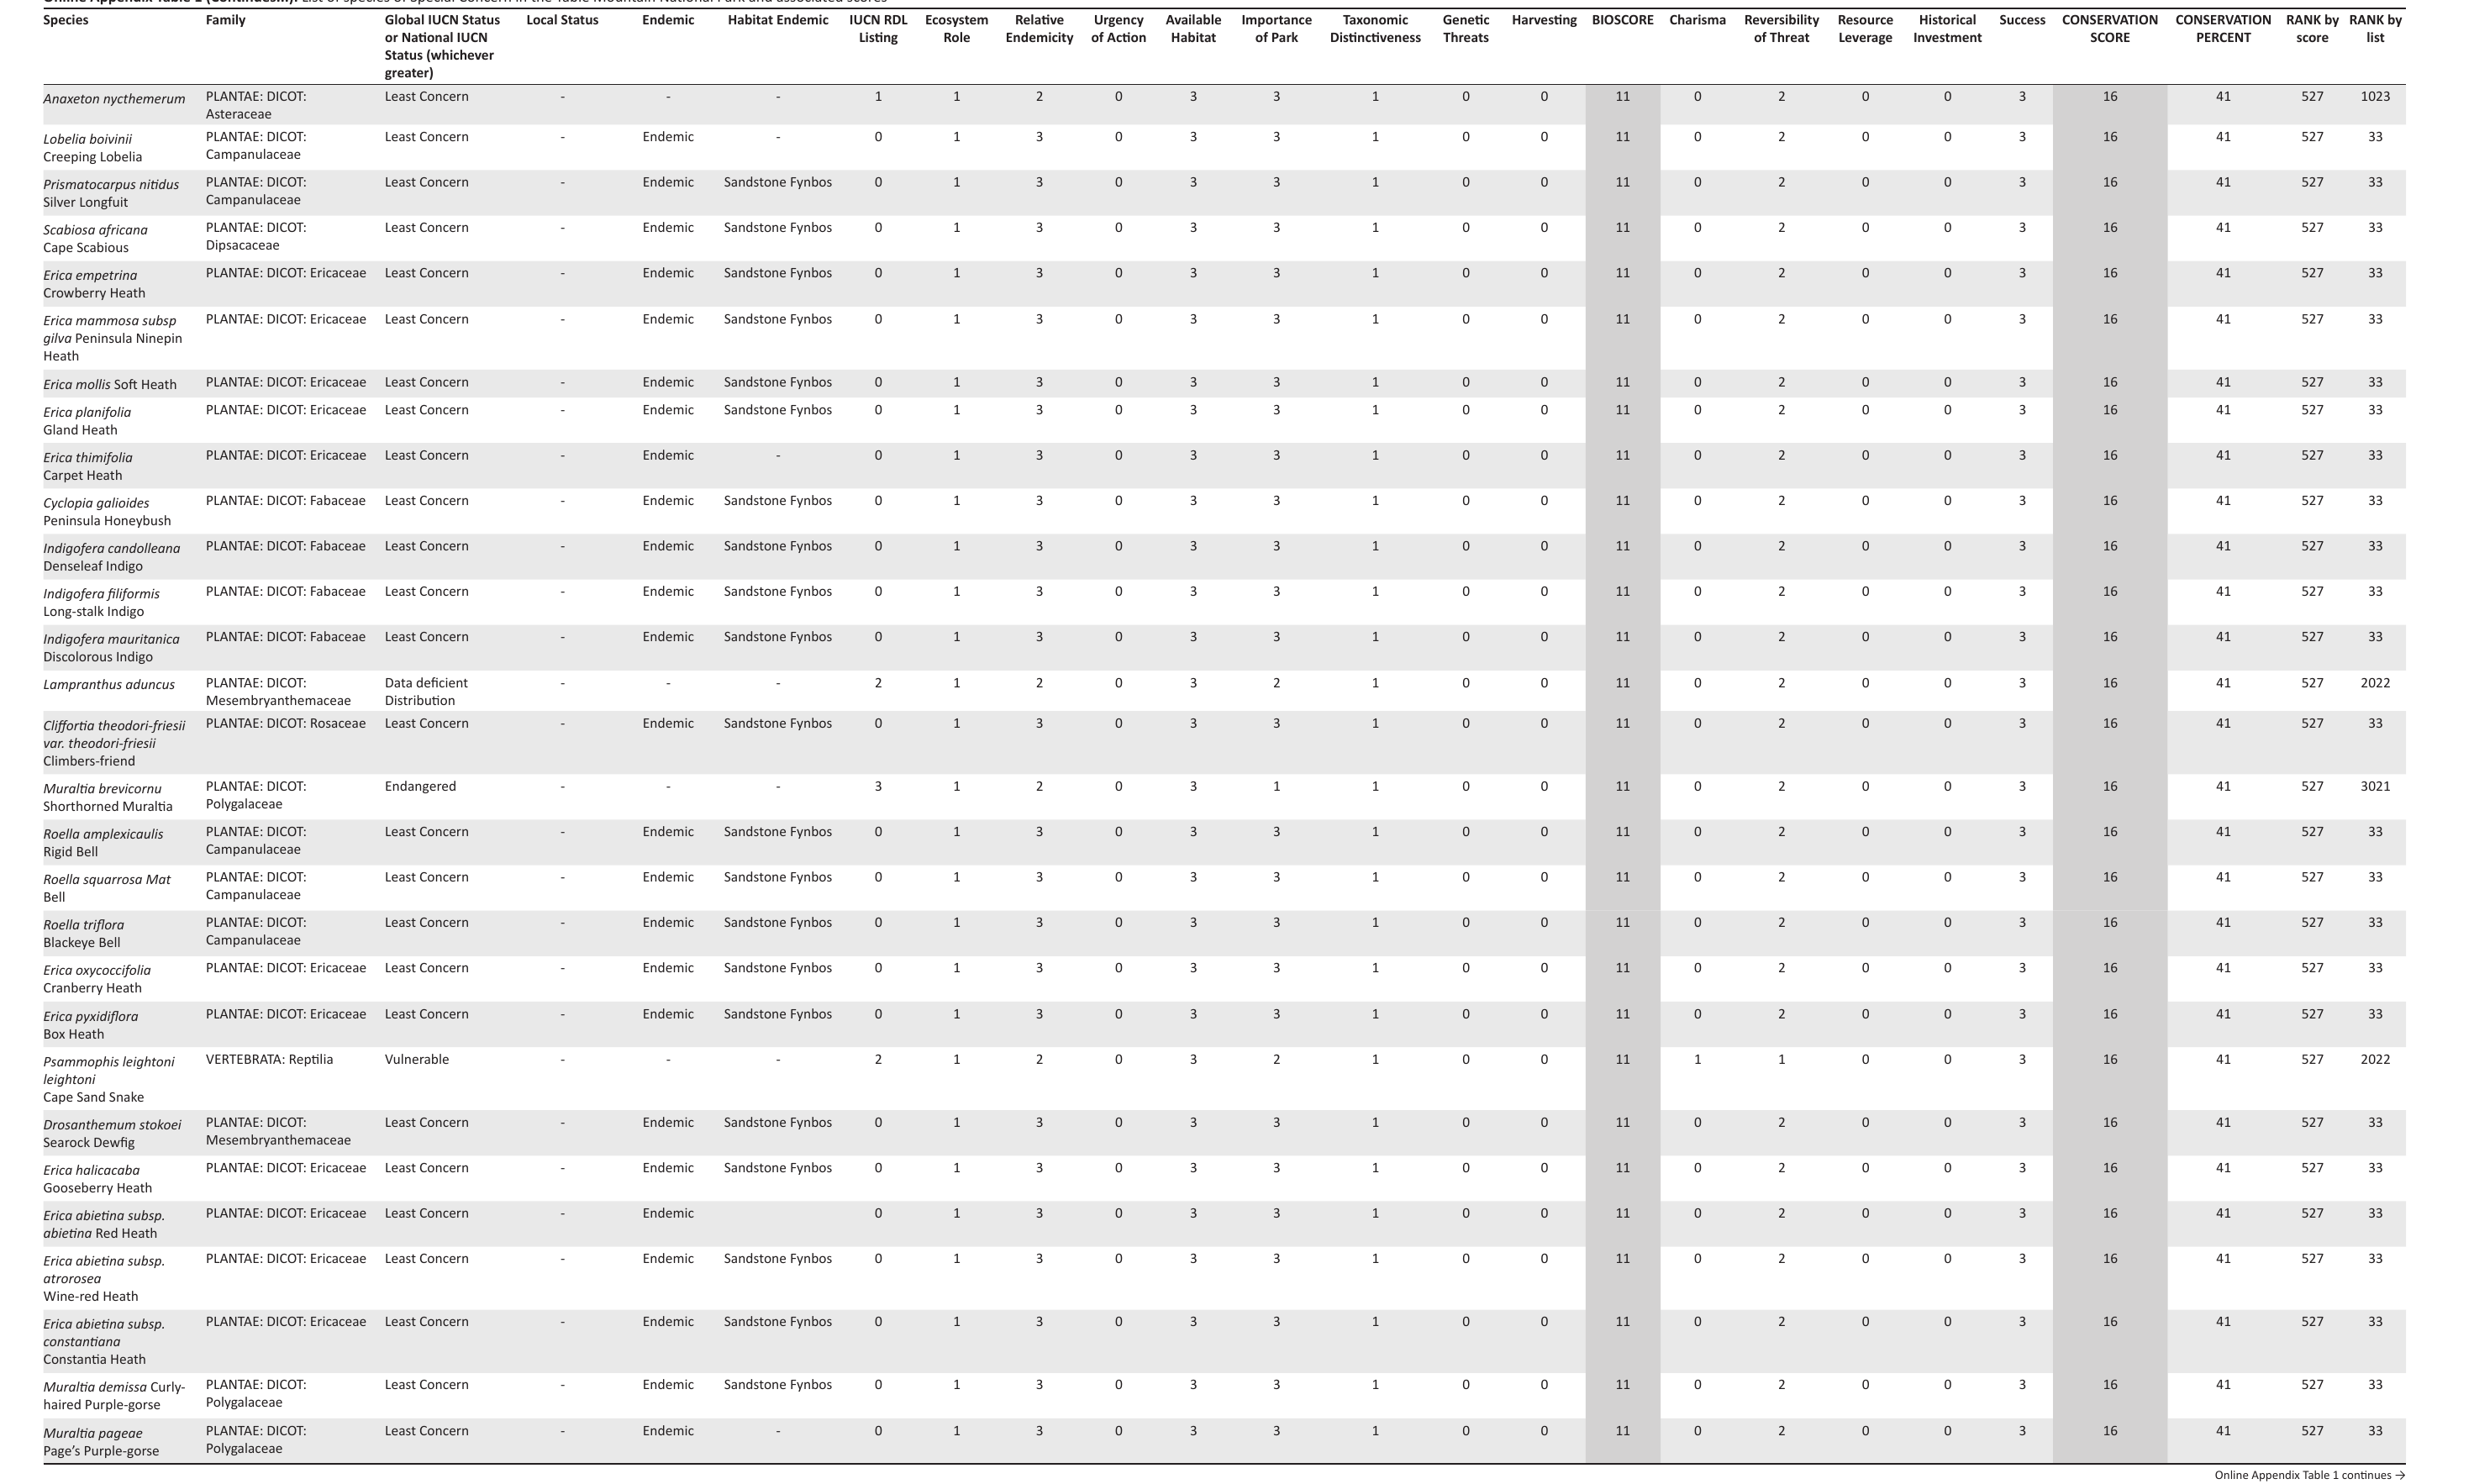
Online Appendix Table 1 (Continues...): List of species of Special Concern in the Table Mountain National Park and associated scores Species